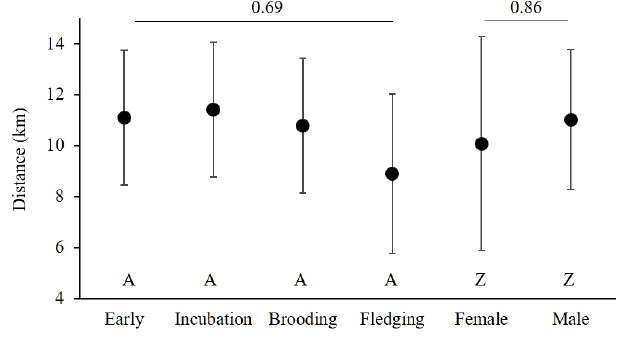
Fig. 3 . Average distance (± 95% confidence interval) flown from the colony to foraging sites of adult Reddish Egrets ( Egretta rufescens ) breeding in the upper Laguna Madre, Texas, during 2010–2016. P-values for stage and sex effects are indicated above bars, differences among stages and between sexes are indicated by letters.